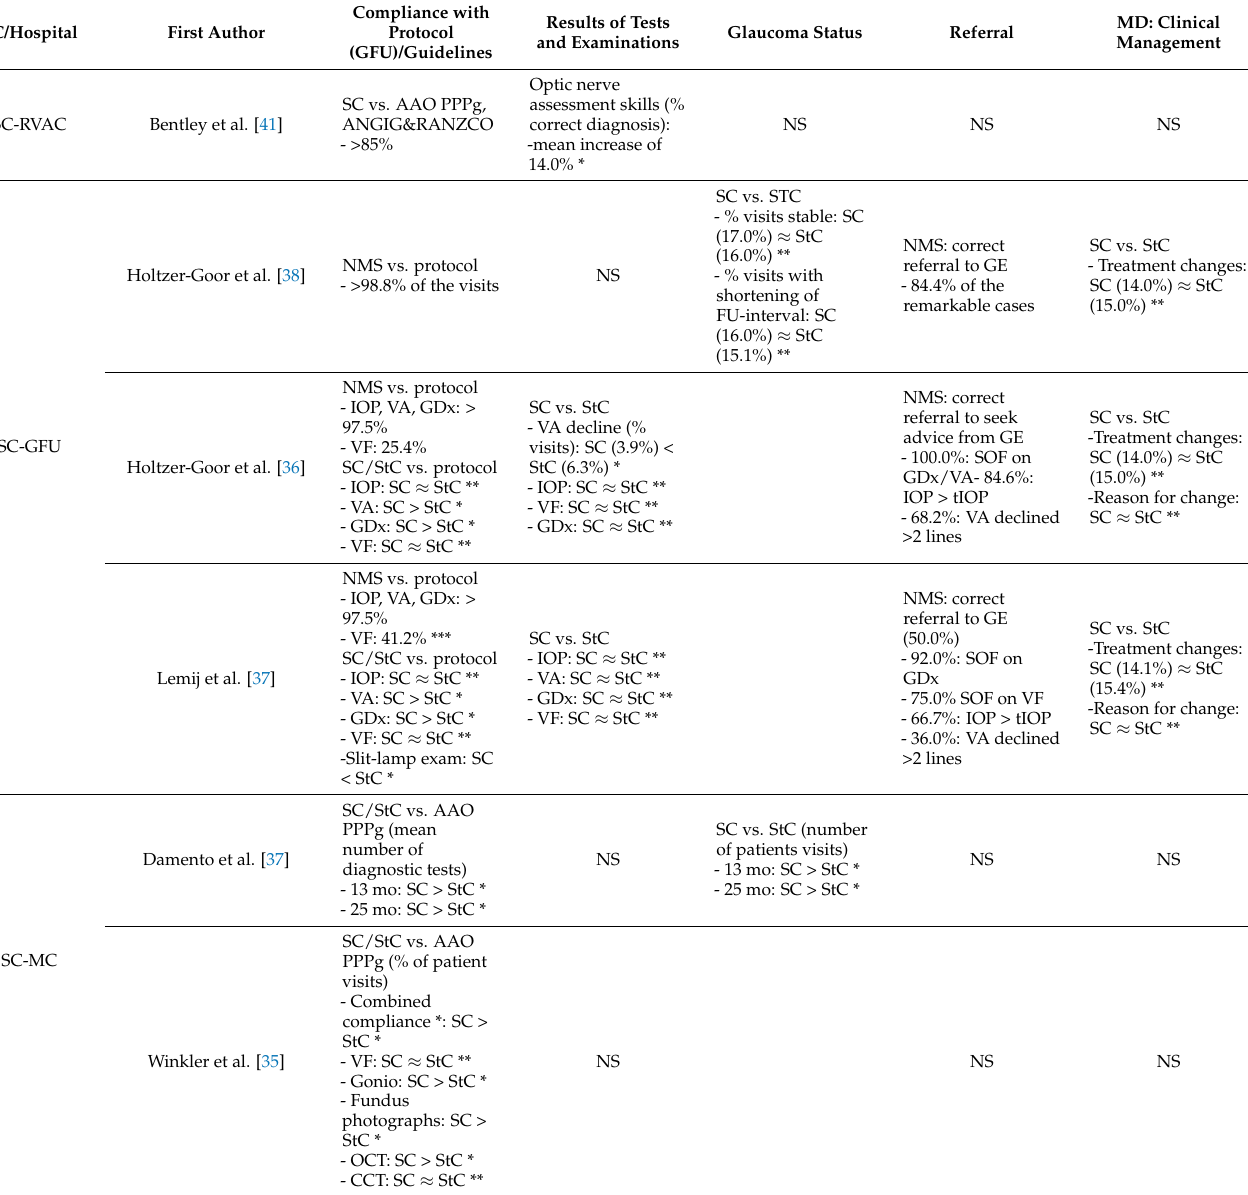
Table 4. The quality of care provided by the non-medical staff and the quality of care provided by the shared care clinic in